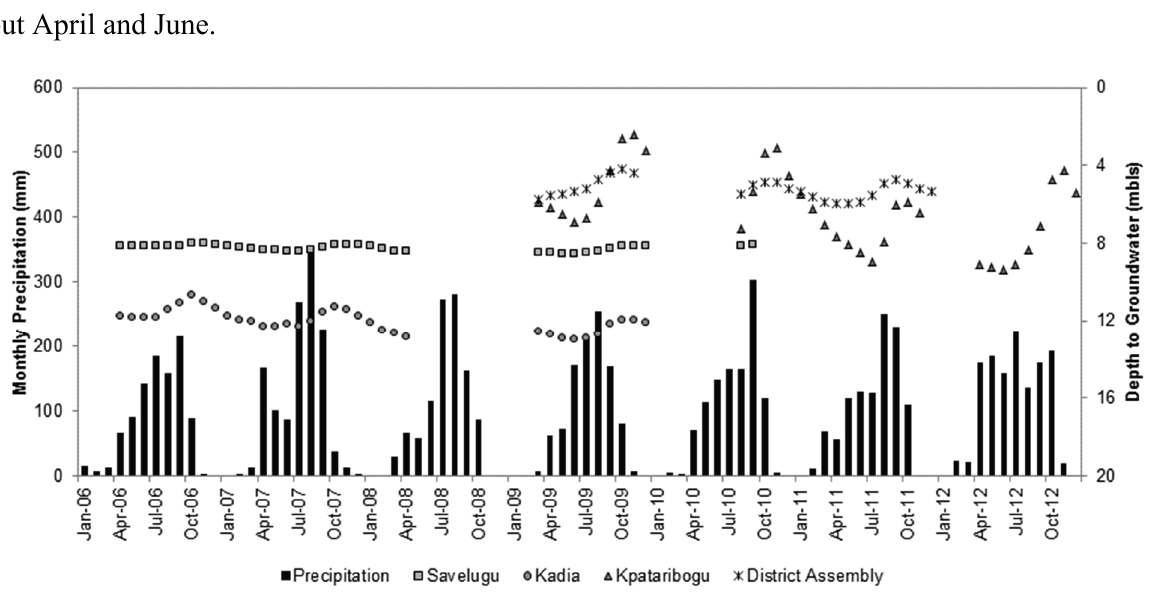
Figure 3. Average monthly precipitation (mm) and groundwater level response measured in meters below land surface (mbls) at the study